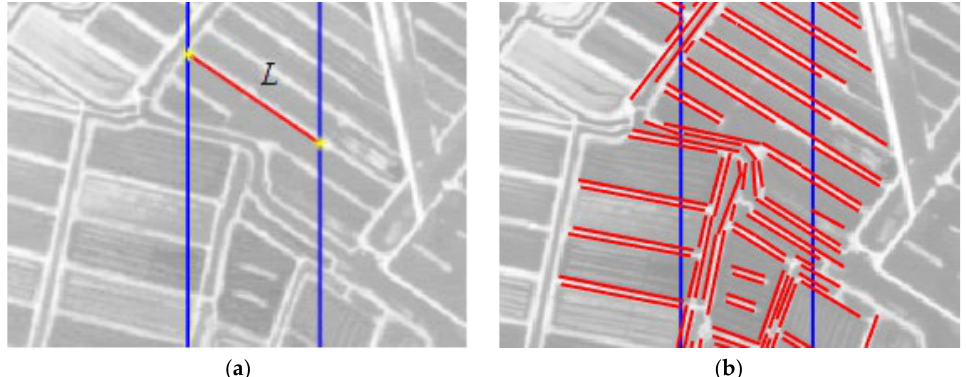
Figure 2. Overlap constraint. ( a ) Reference image; ( b ) search image. L is the reference line on the reference image and the blue lines on both images are the corresponding epipolar lines for the endpoints of the L . The red feature lines on the search image are a set of candidates that satisfy the overlap constraint.